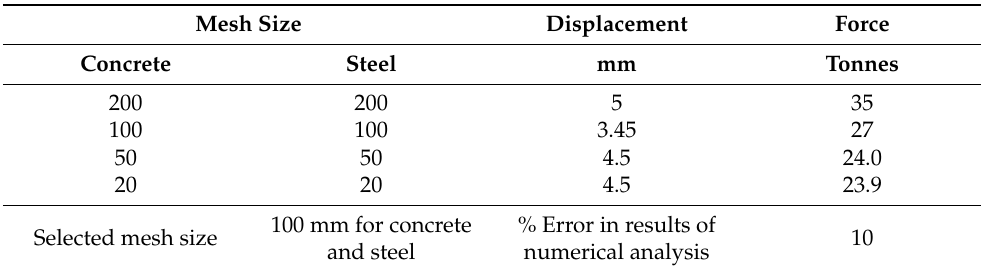
Figure 6. Numerical model based on the experimental work of Maximos et al. [18]. Table 3. Results of model